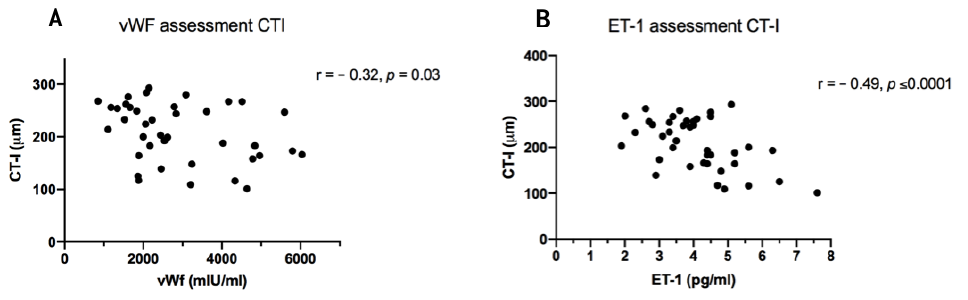
Figure 5. ( A ) Scatterplot of plasma von Willebrand factor (vWF) levels and choroidal thickness location I (CT-I). ( B ) Scatterplot of plasma endothelin-1 (ET-1) levels and CT-I. Pearson correlation coefficients are shown (top right).